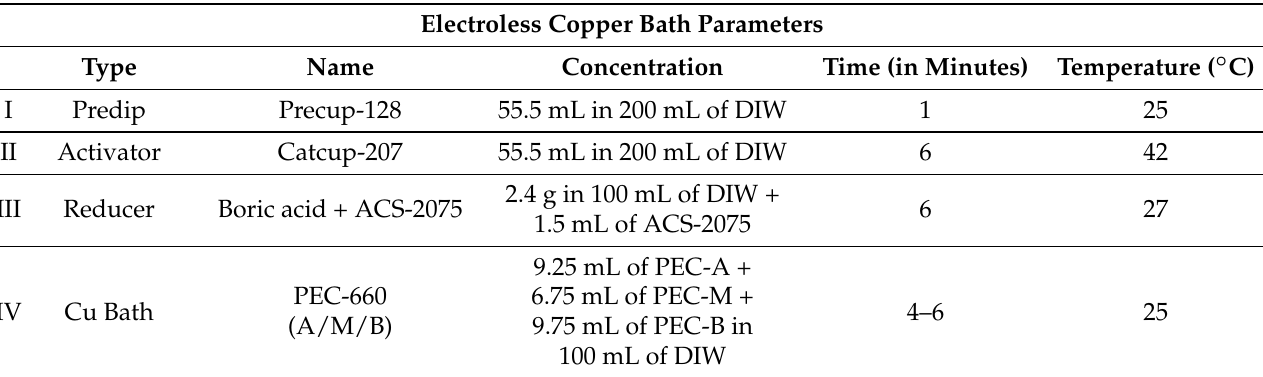
Table 1. Process parameter of the electroless Cu Bath for perfect metallization. Electroless Copper Bath